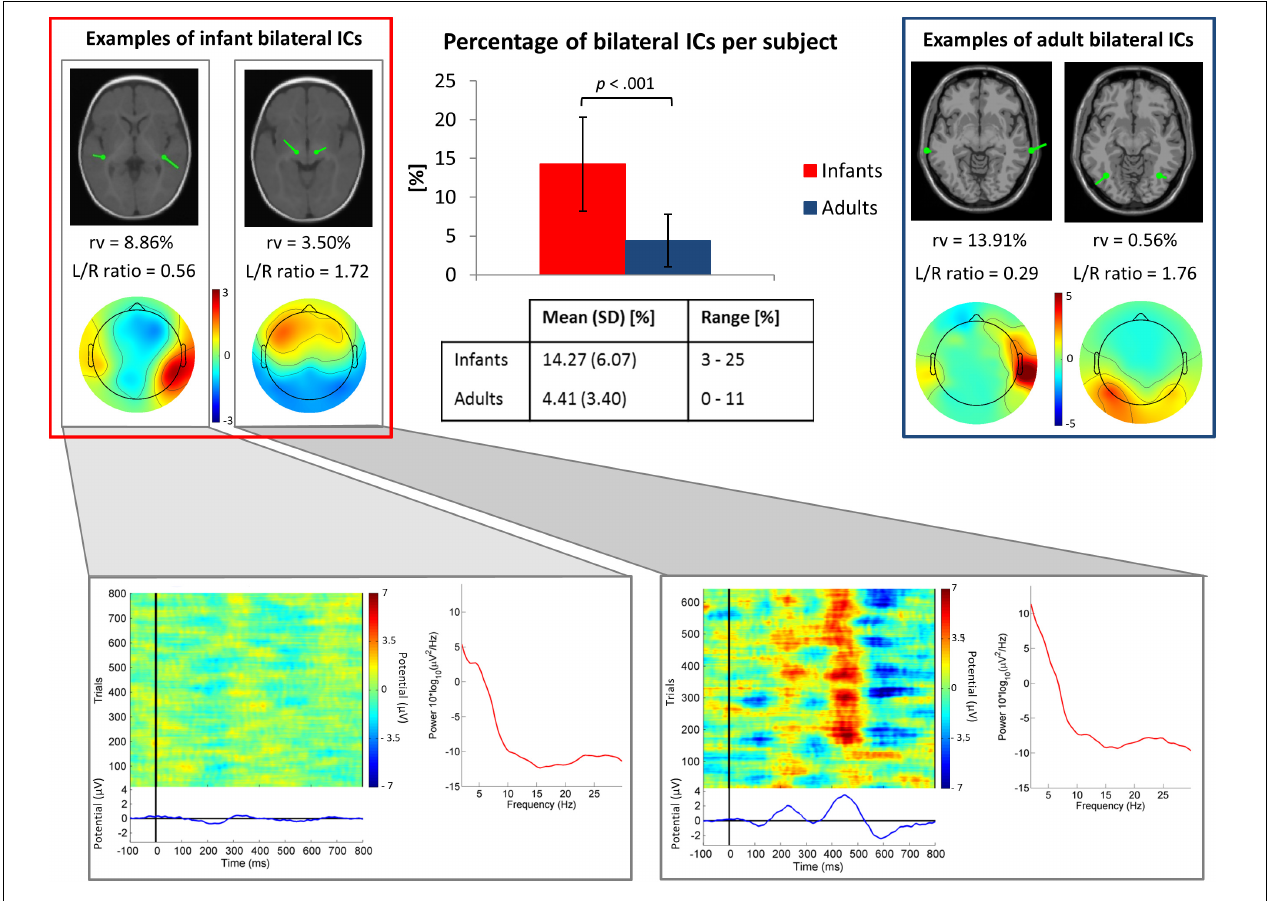
FIGURE 3 | Top center. Bar graph showing the mean percentage of ICs judged to be bilateral per subject. The group difference was significant ( p < 0.001 by independent sample t -test). Error bars present standard deviations. In the table, mean values, standard deviations (SD) and ranges (min-max) of the percentage of bilateral ICs for each group are shown. Top left and right boxes. Example bilateral infant (left) and adult (right) IC scalp maps and dipole models. Bottom. Power spectra, ERP-image plots, and mean ERPs for the two example infant bilateral ICs. Here all trials were included in order of presentation, independent of stimulus type.